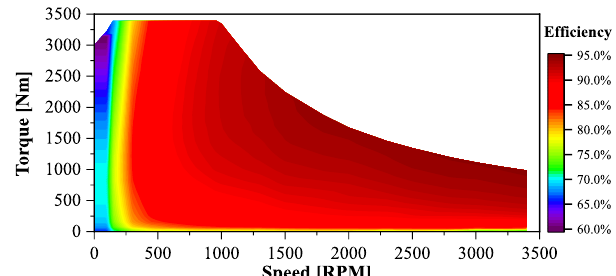
Figure 10. Efficiency map for the 36/24 ERCV SRM.